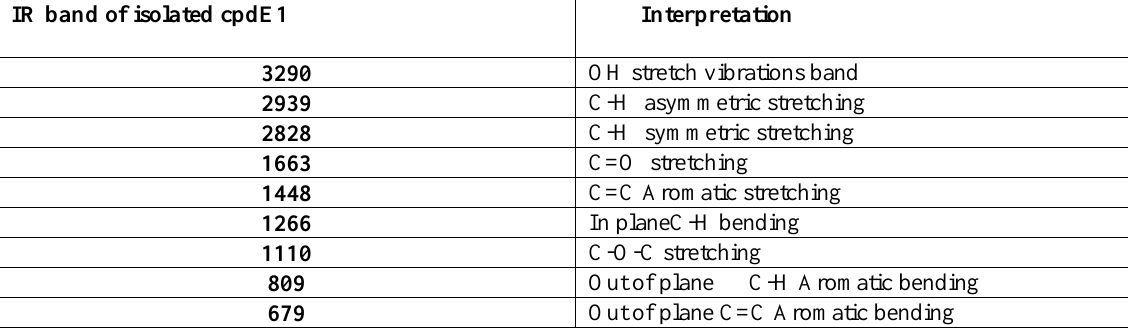
Figure 6. IR spectrum of isolated cpdE1 Table3. interpretation of the IR bands for E1are shown below IR band of isolated